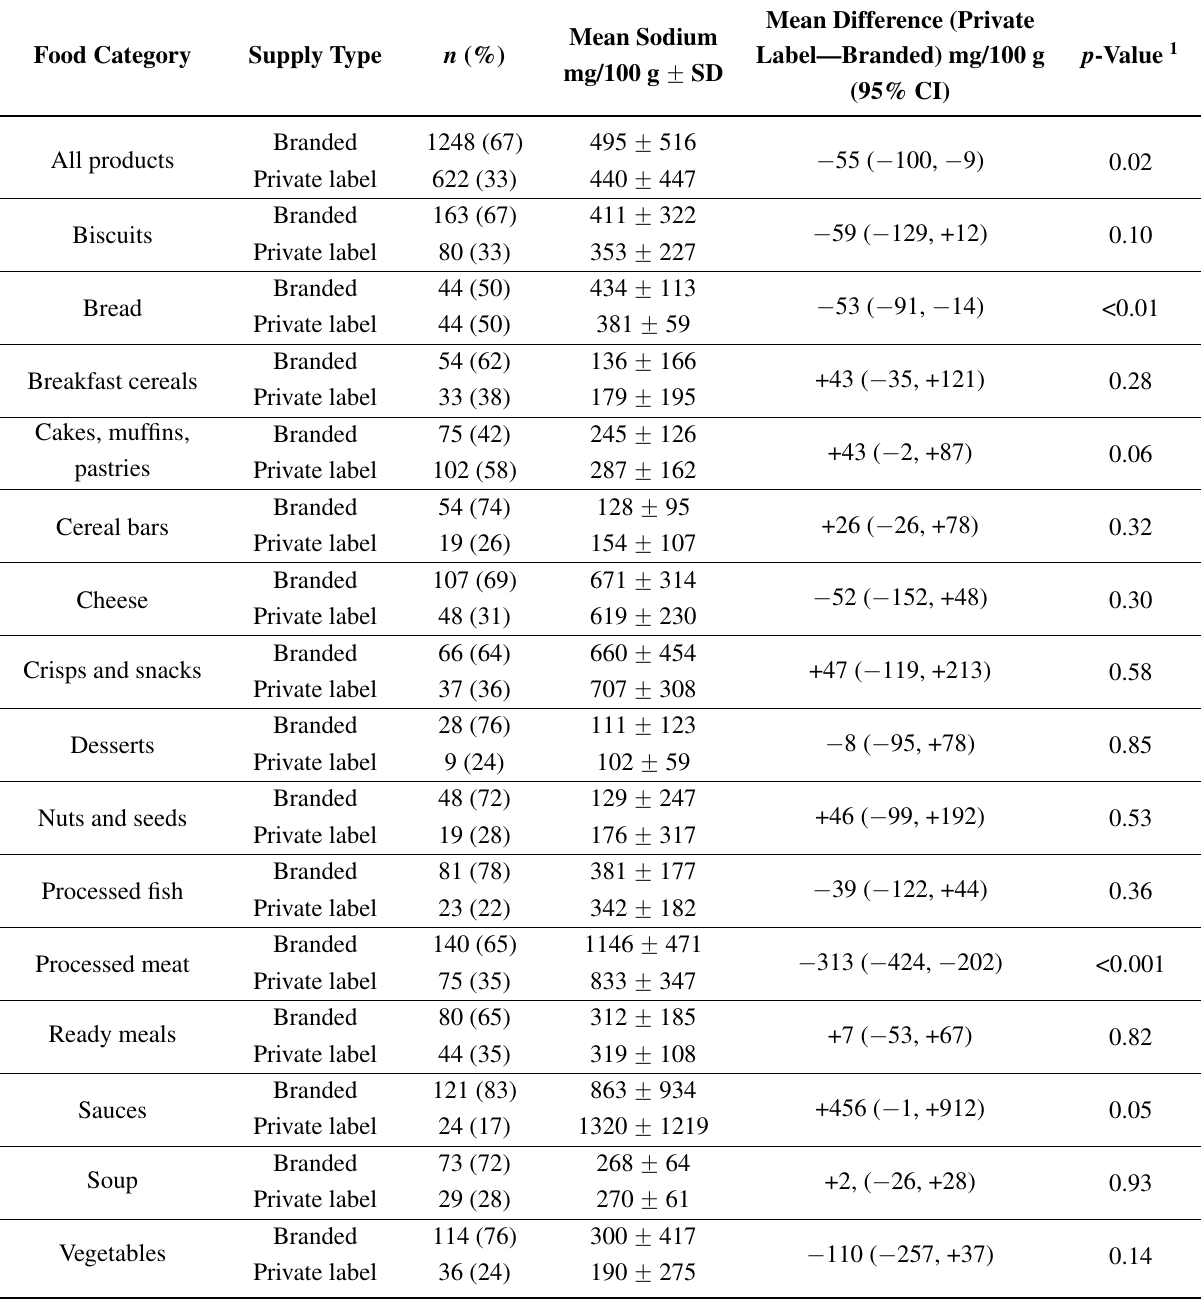
Table 3. Mean sodium levels (mg/100 g) in supermarket private label and branded products new to the supermarket shelves in 2013 and the differences between them, overall and for 15 major food